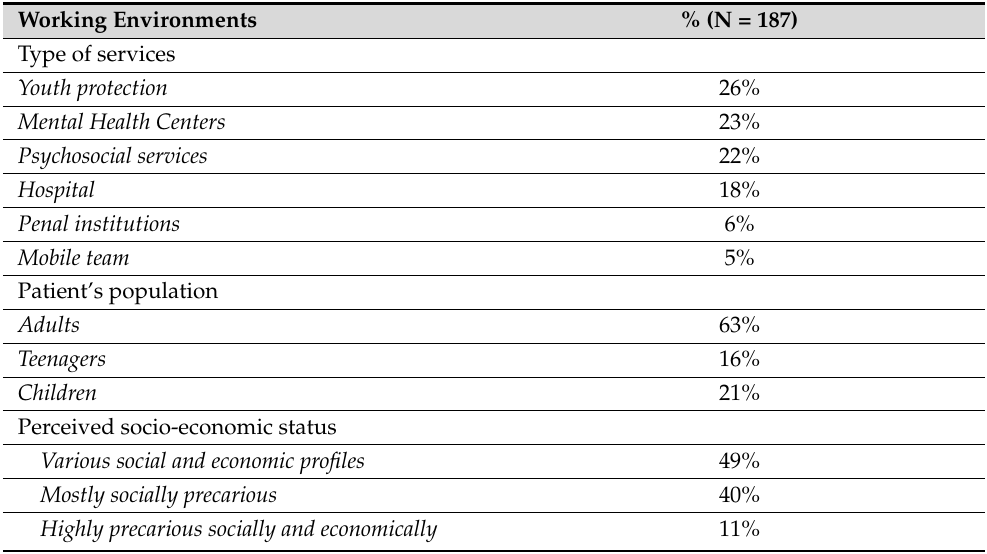
Table 3. Prevalence rate for social professionals’ characteristics of the psychologists’ sample (N = 187) and their working